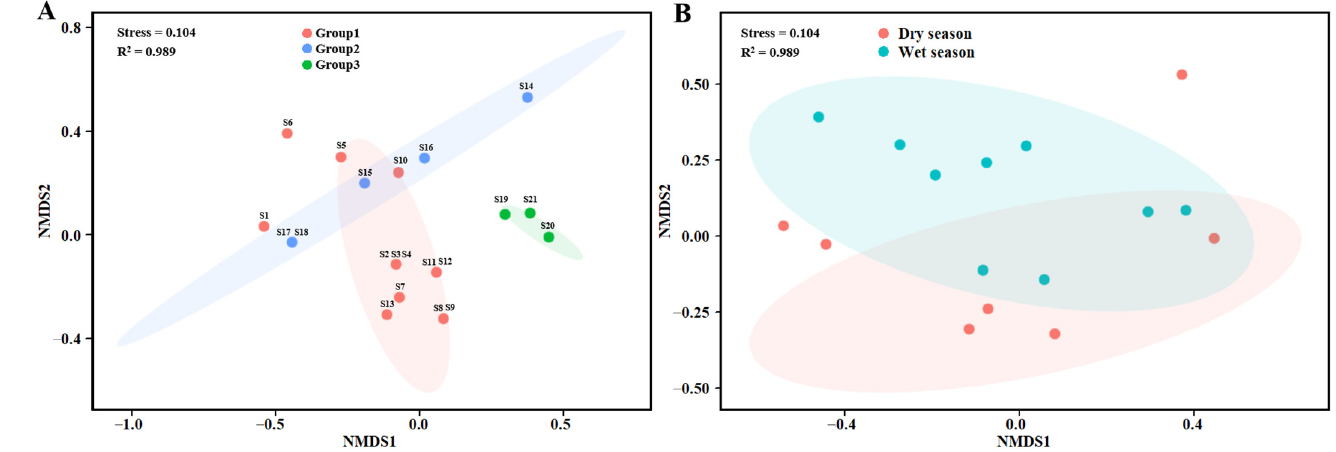
Figure 4. NMDS ordination of spatial ( A ) and temporal ( B ) variation in the fish community.